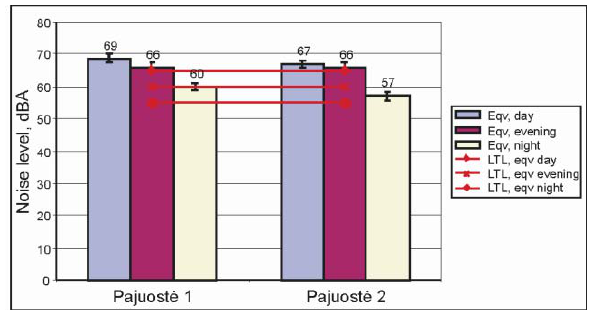
Fig. 22. Dynamics of equivalent noise levels in Pajuostė street within twenty four hours